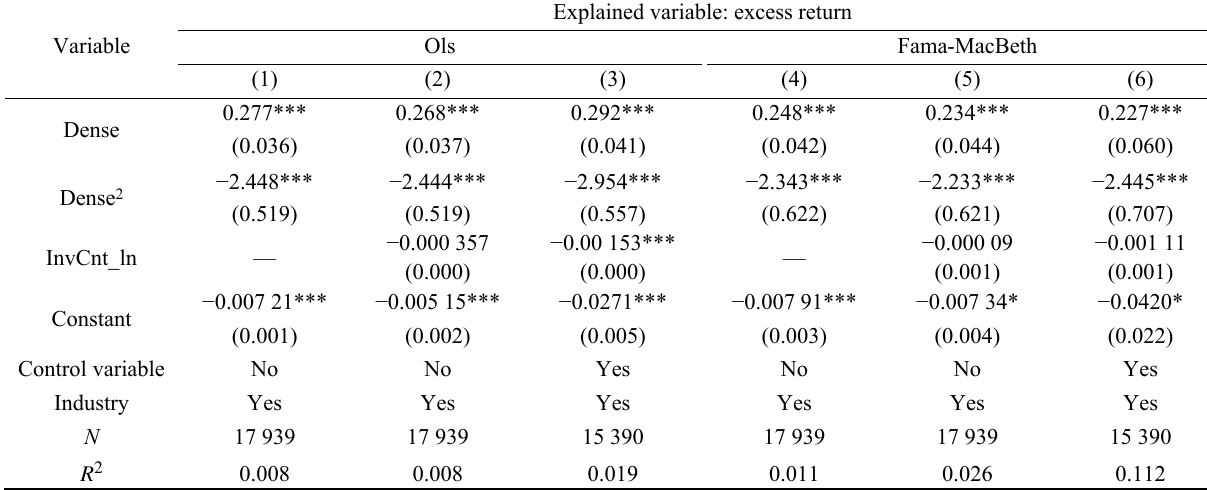
Table 14 Information diffusion speed and individual stocks’ rate of return.